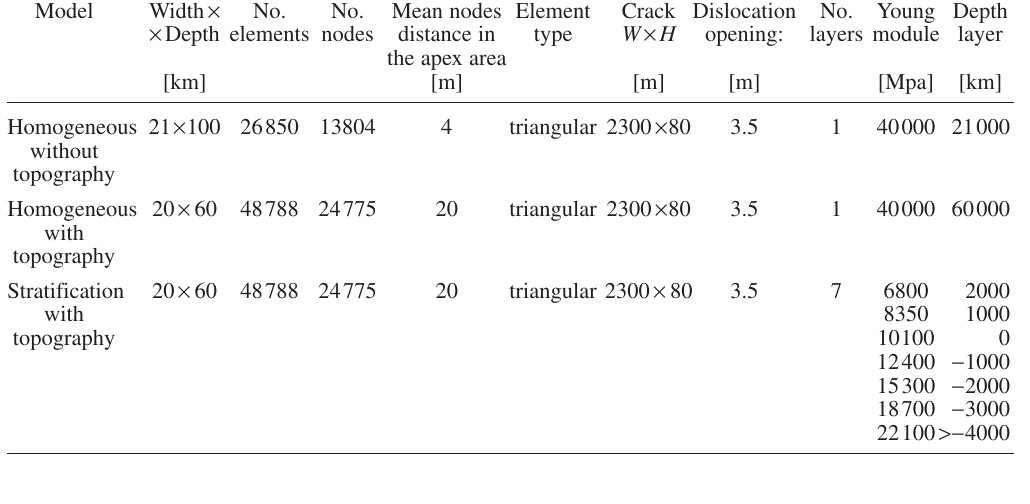
Table II. Parameters of FEM analysis of a dike intrusion for the different medium analysed: elastic homoge- neous half-space without topography; elastic homogeneous half-space with topography; medium with topogra- phy and seven stratification